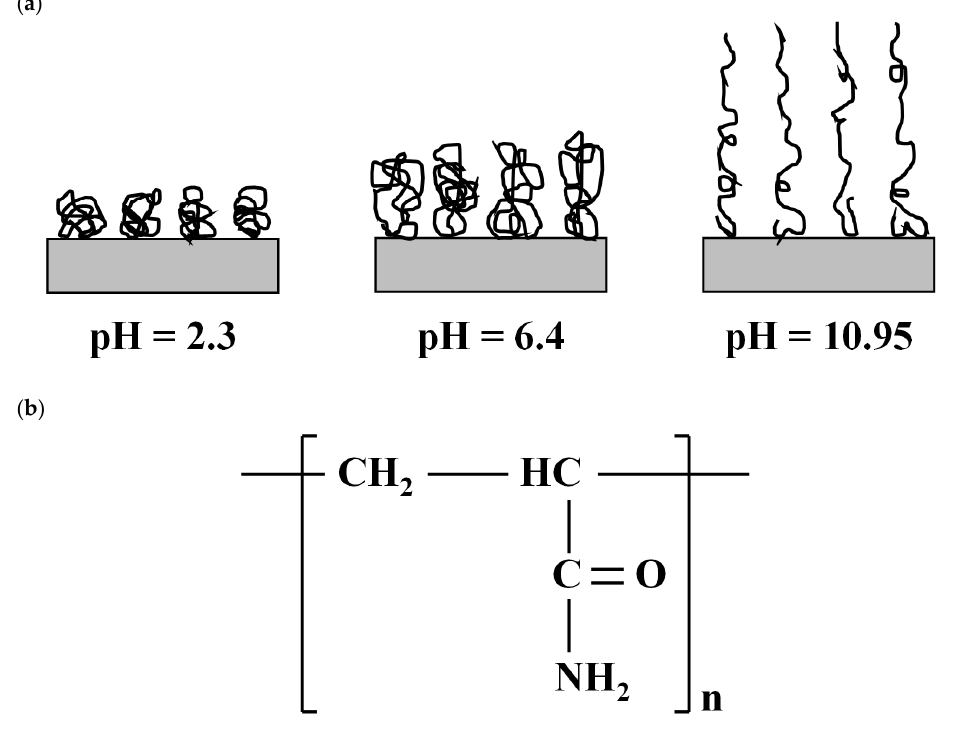
Figure 2. Nonionic polyacrylamide (PAM): ( a ) schematic drawing of the conformational state of adsorbed PAM at different pH conditions (after [31]) and ( b ) chemical structure of PAM (after [33]).